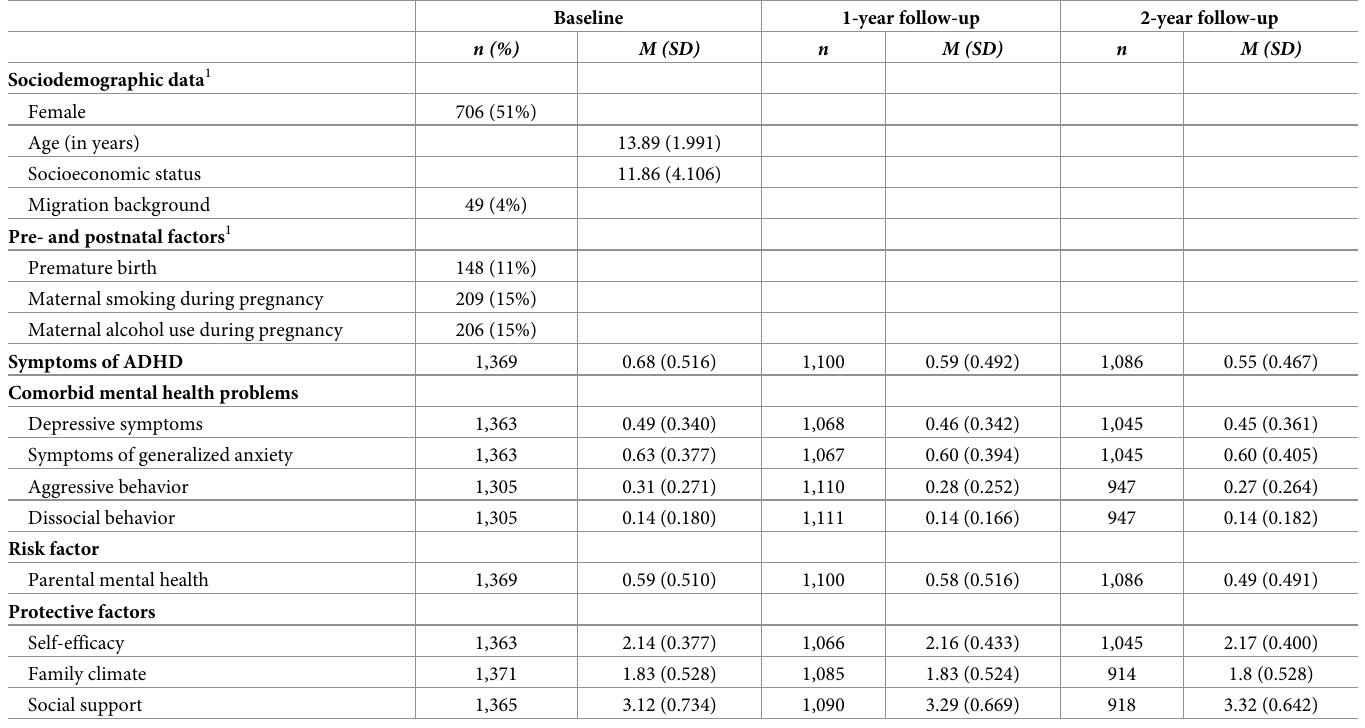
Table 1. Description of the analyzed sample of children and adolescents aged 11 to 17 years (at baseline).